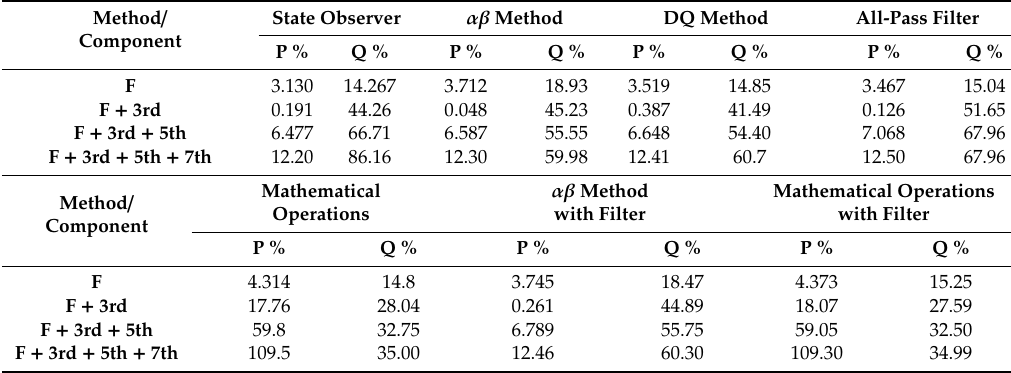
Table 3. Experimental results error %.